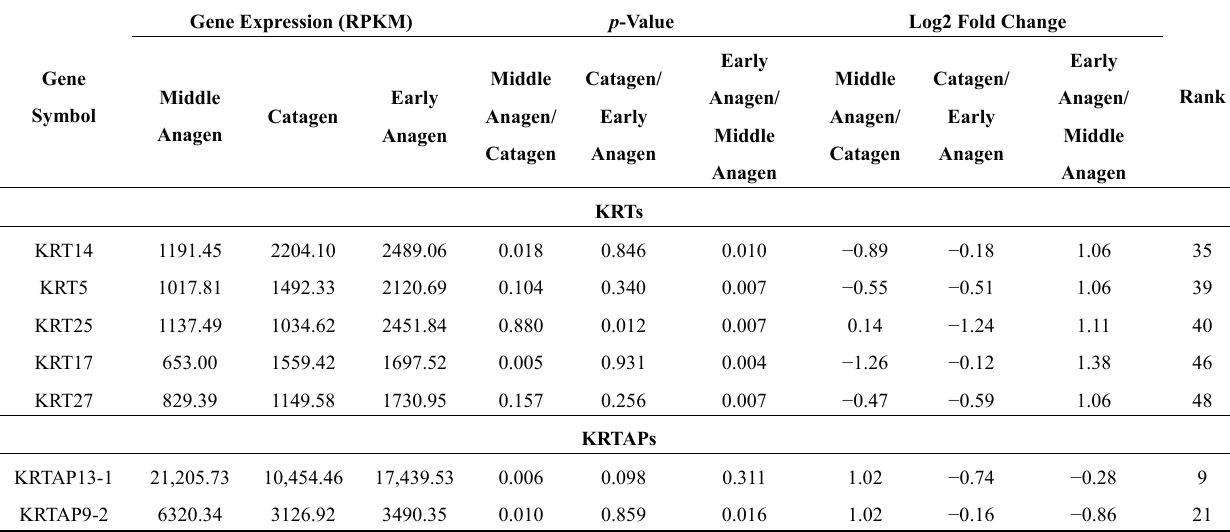
Table 1. Differentially expressed KRT and KRTAP genes in the wool follicle bulb of sheep during phase